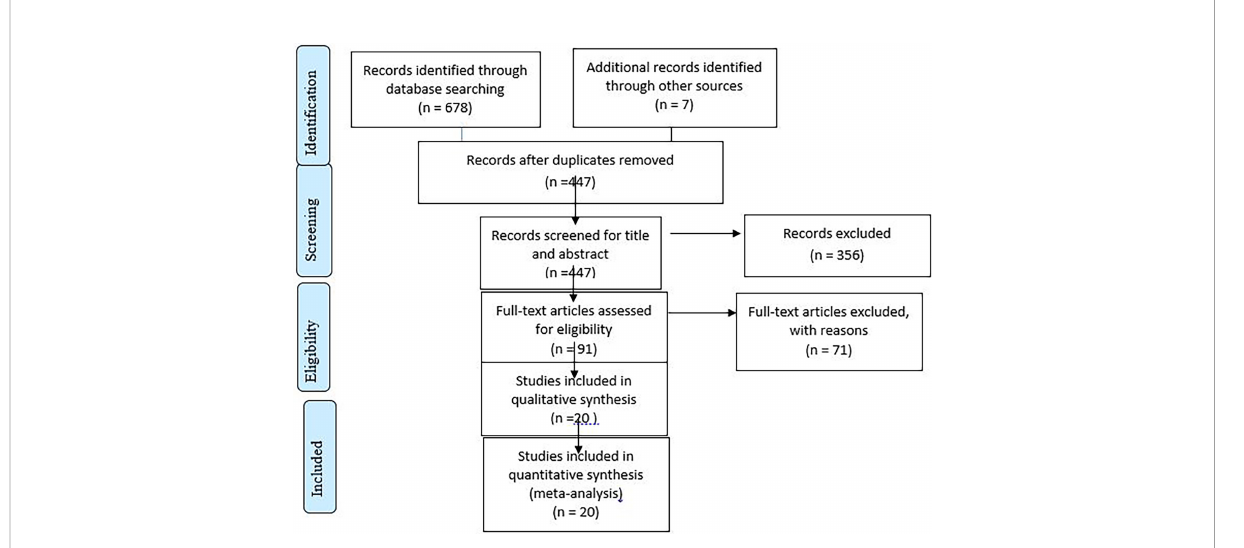
FIGURE 1 Flow chart illustrating the process of search and selection of studies included in the present systematic review and